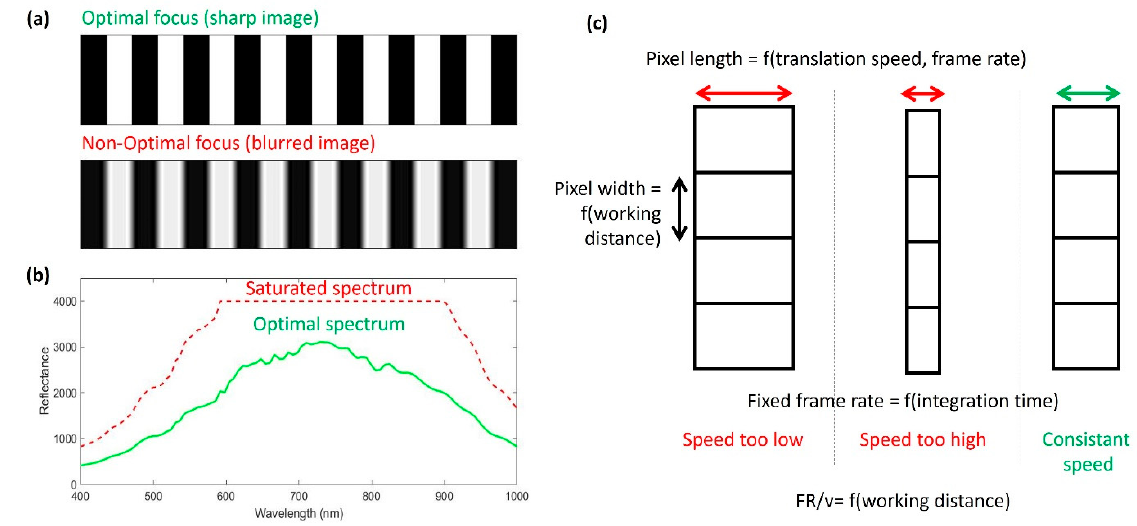
Figure 5. Representation of the different acquisition parameters to be adjusted: ( a ) the focus to obtain a sharp image; ( b ) the integration time to avoid saturating the spectra; ( c ) the link between several parameters to obtain a square pixel.